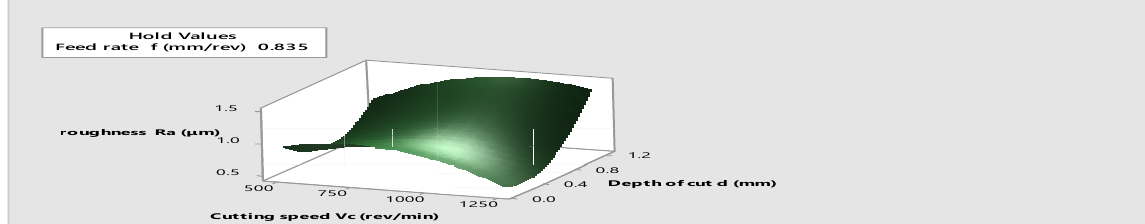
Figure 15: 3D surface graph for tool wear with JBC